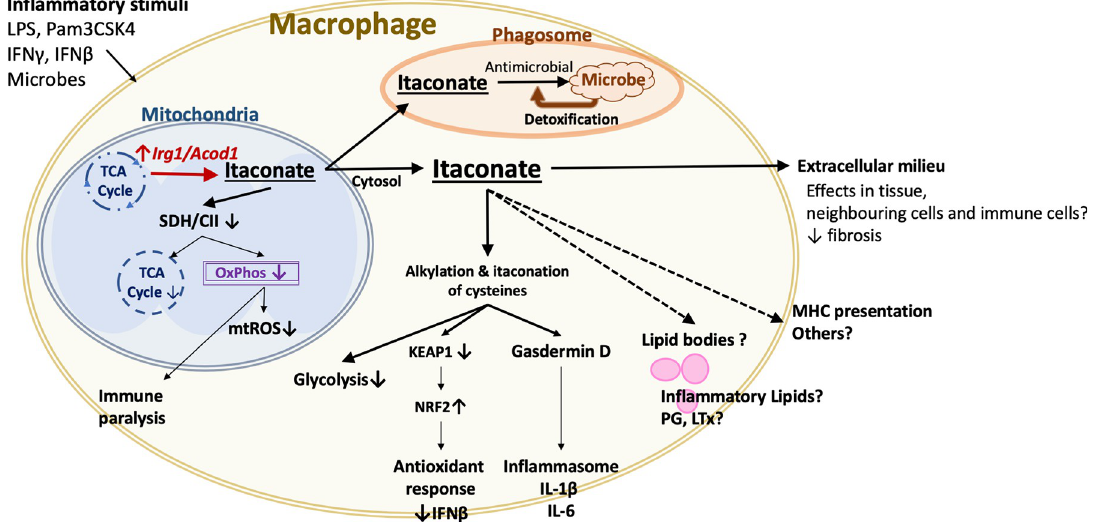
Fig 1. Itaconate modifies immune responses by controlling metabolism and posttranscriptionally regulating immune cascades, which is posited to prevent excessive tissue damage. I AU : TheabbreviationlistofFig 1 hasbeenupdated : Pleaseverifythatallentriesarecorrect : FN β , interferon beta; IFN γ , interferon gamma; IL, interleukin; Acod1/Irg1 : aconitate decarboxylase 1/immune-responsive gene 1; KEAP1, Kelch-like ECH-associated protein 1; LPS, lipopolysaccharide; LTx, leukotriene; MHC, major histocompatibility complex; mtROS, mitochondria-derived reactive oxygen species; NRF2, nuclear factor erythroid 2–related factor 2; OxPhos, oxidative phosphorylation; PG, prostaglandin; SDH/CII, succinate dehydrogenase and complex II of the respiratory chain; TCA cycle, tricarboxylic acid